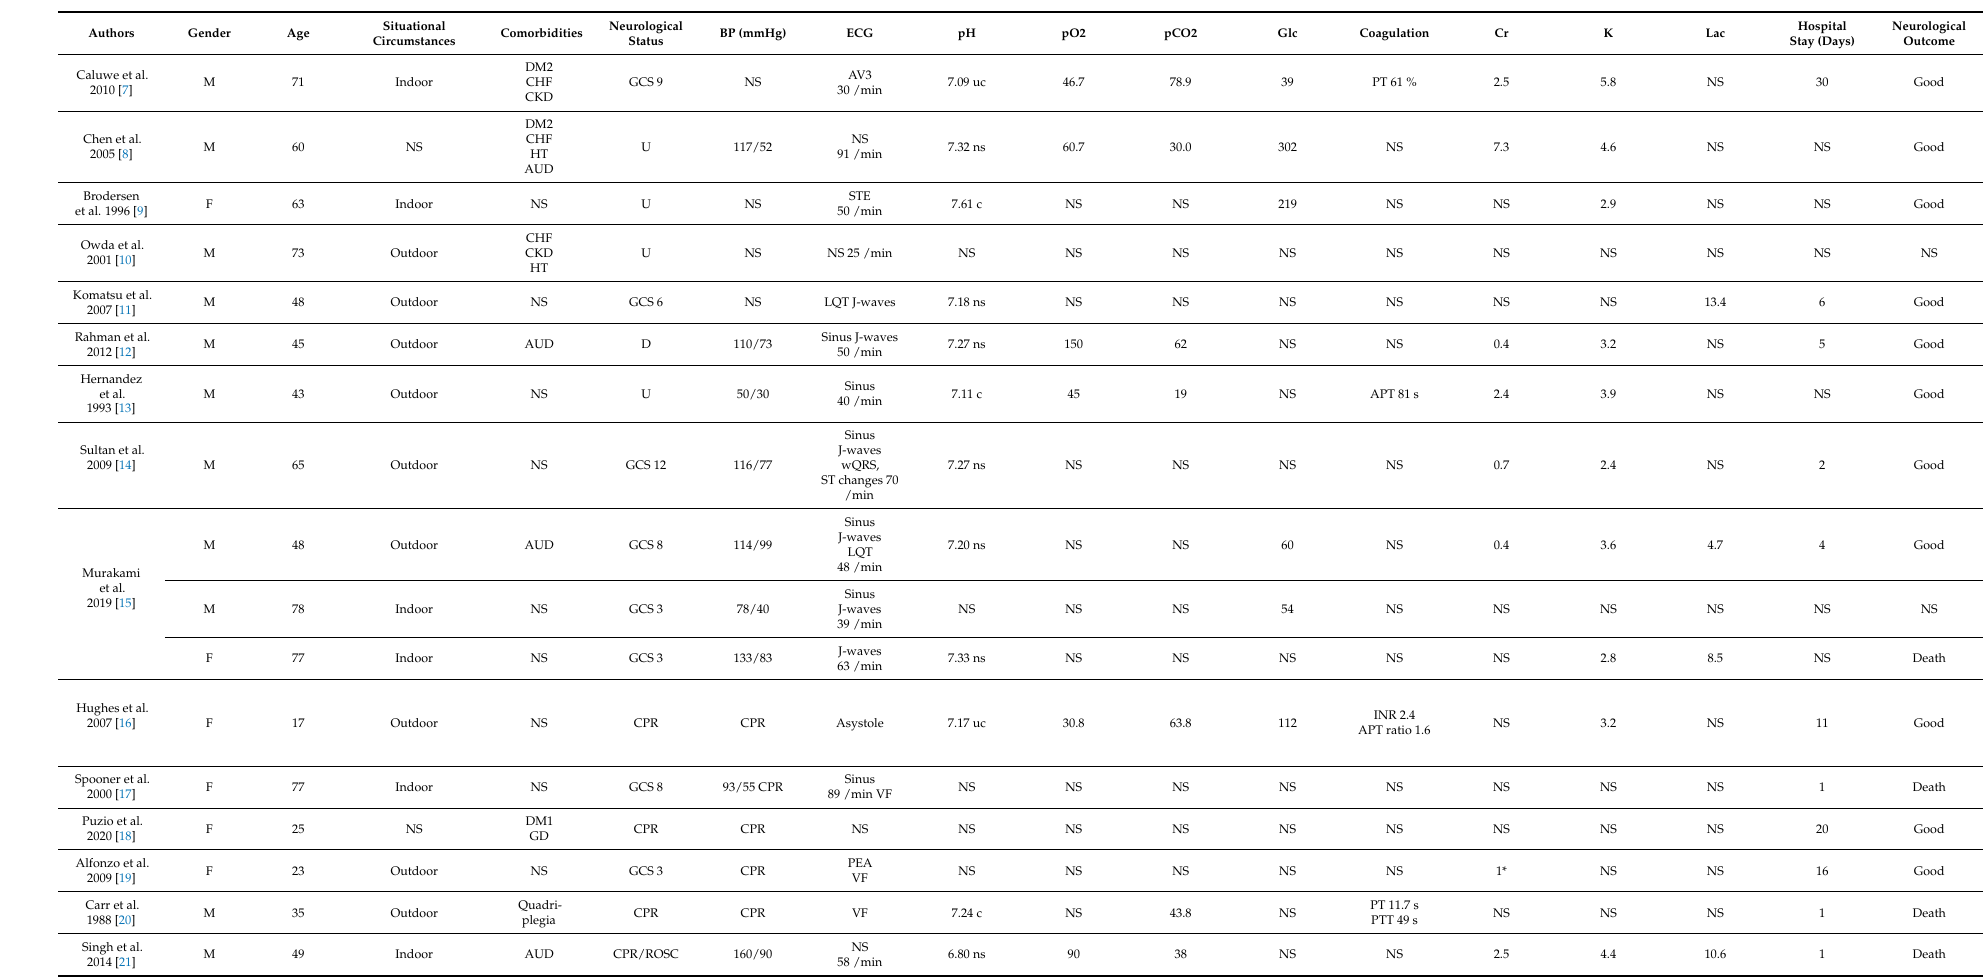
Table 3. Patient